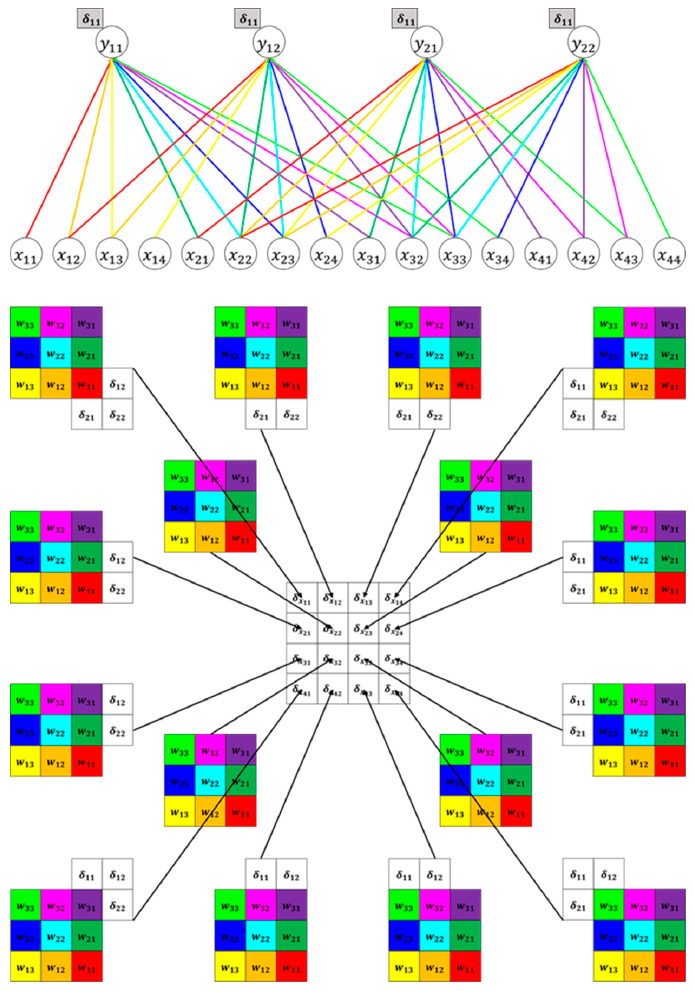
Figure 13. Backpropagation image.